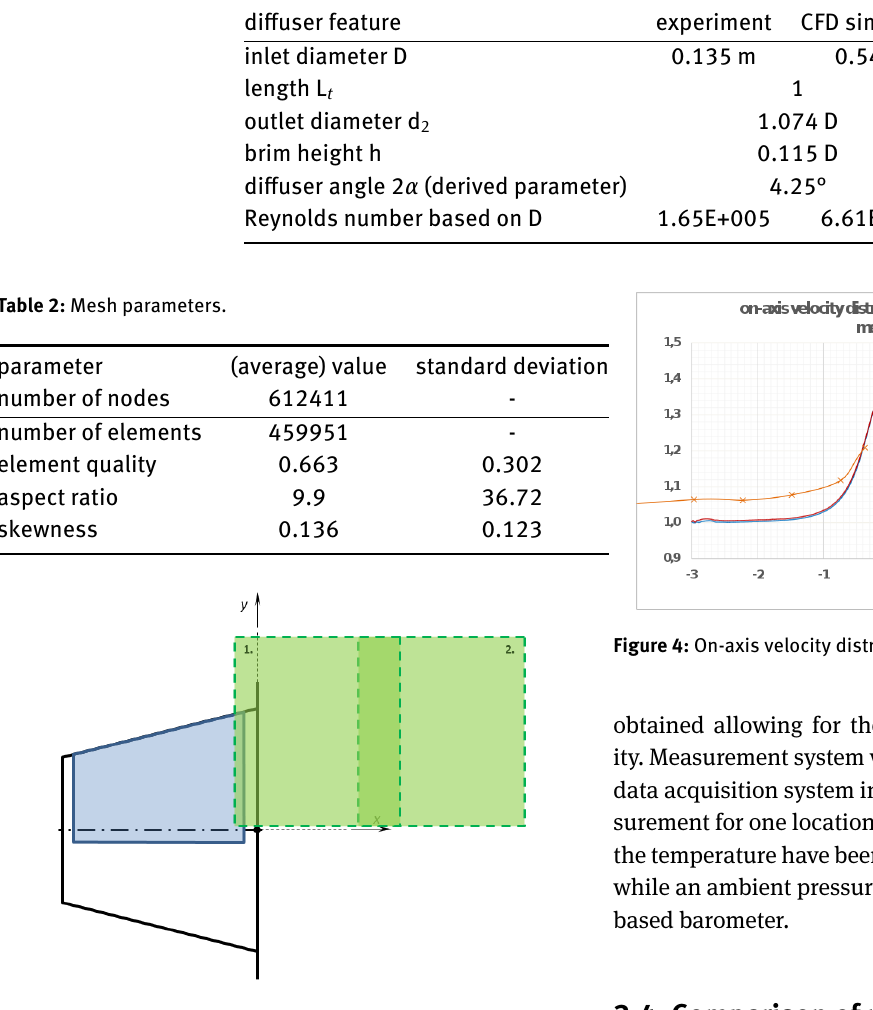
Figure 3: Arrangement of measurement planes.